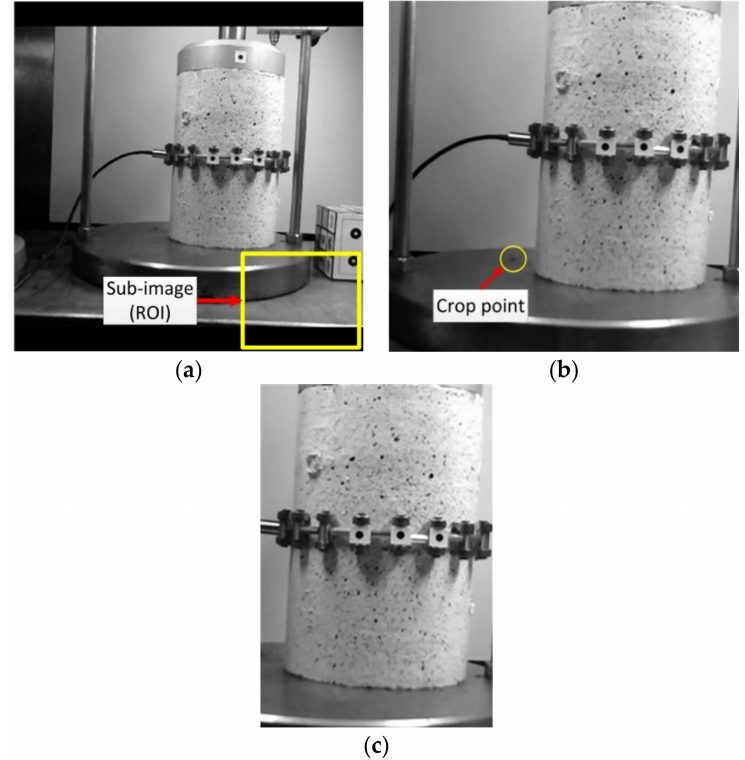
Figure 6. Image motion correction procedure: ( a ) ROI definition on a synthetically moved image; ( b ) image correction and determining a crop point; ( c ) Cropped corrected image as the final output